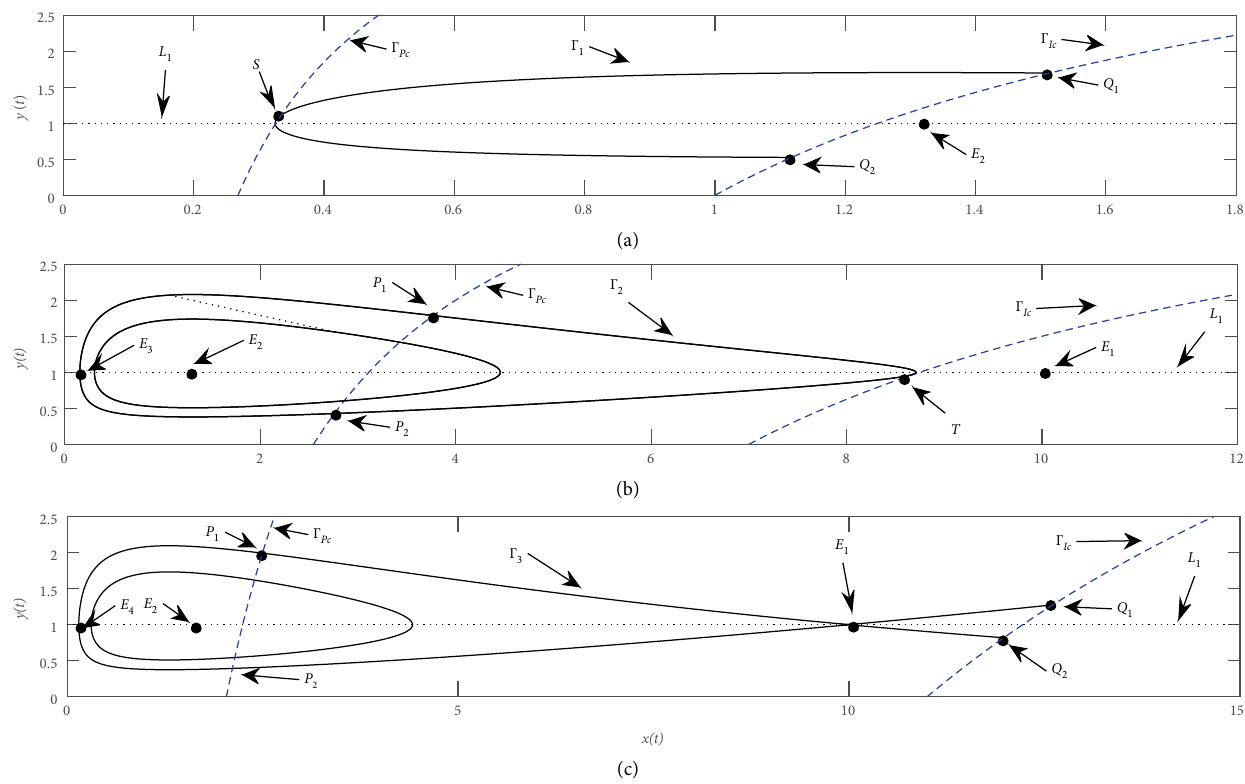
∗ ∗ and . (a) , (b) 2 2 < (퐴푇/훼) < 푥 푥 퐴푇/훼 ≤ 푥 ( 퐵 1 ) , ( 퐵 2 ) ( 𝐵 3 ) , is a trajectory tangent to curve at point Γ 2 Γ 𝐼𝑐 푇 = ( 푥 𝑇 , 푦 𝑇 ) and , and its upper and lower right branches touch curve ( 푥 𝑃 2 , 푦 𝑃 2 )